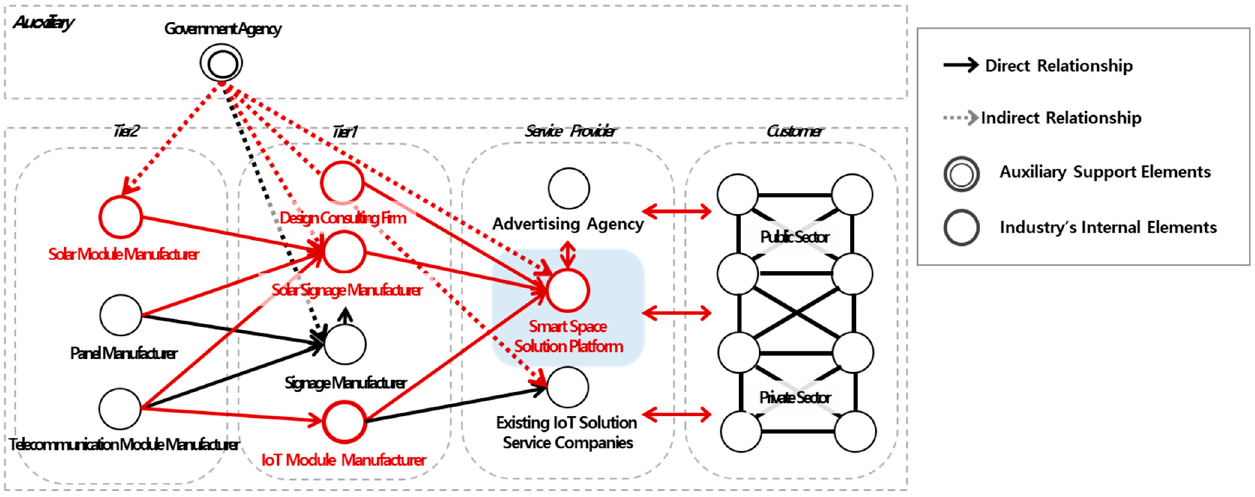
Figure 6. TO-BE model.